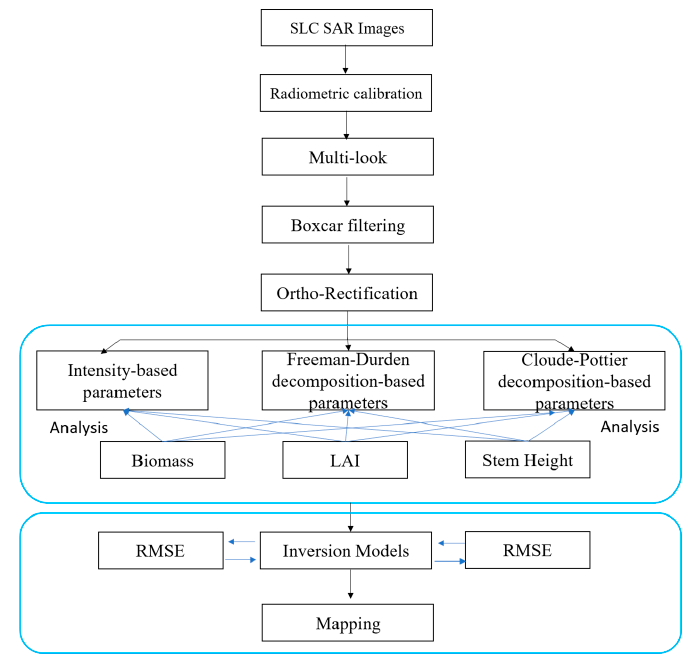
Figure 2. Synthetic aperture radar (SAR) data processing and the study flowchart. SLC, single-looking complex; LAI, leaf area index; RMSE, root mean square error.